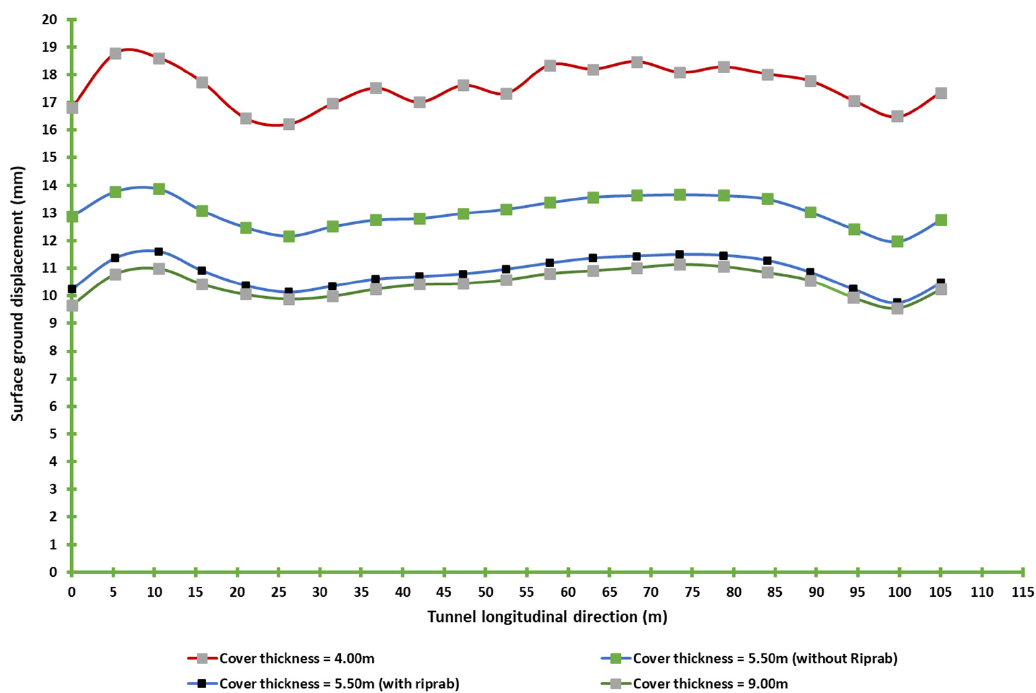
Figure 18. Displacement of surface ground during the construction stage.